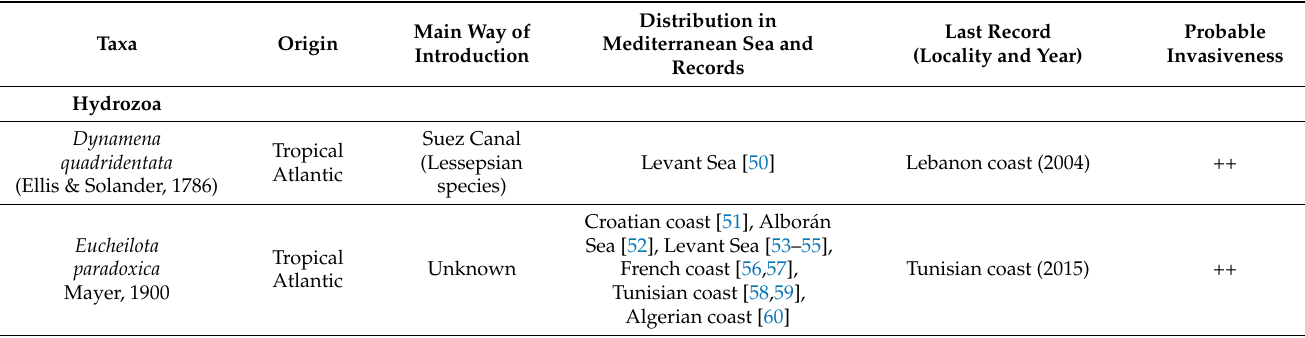
Table 1. Cnidaria potential invaders of the Italian